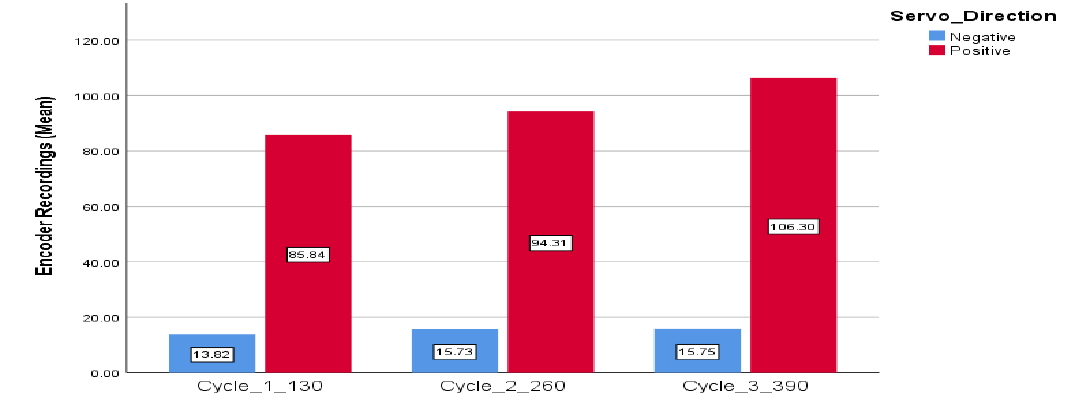
Figure 8. Clustered bar (mean) of encoder recordings with servo directions.